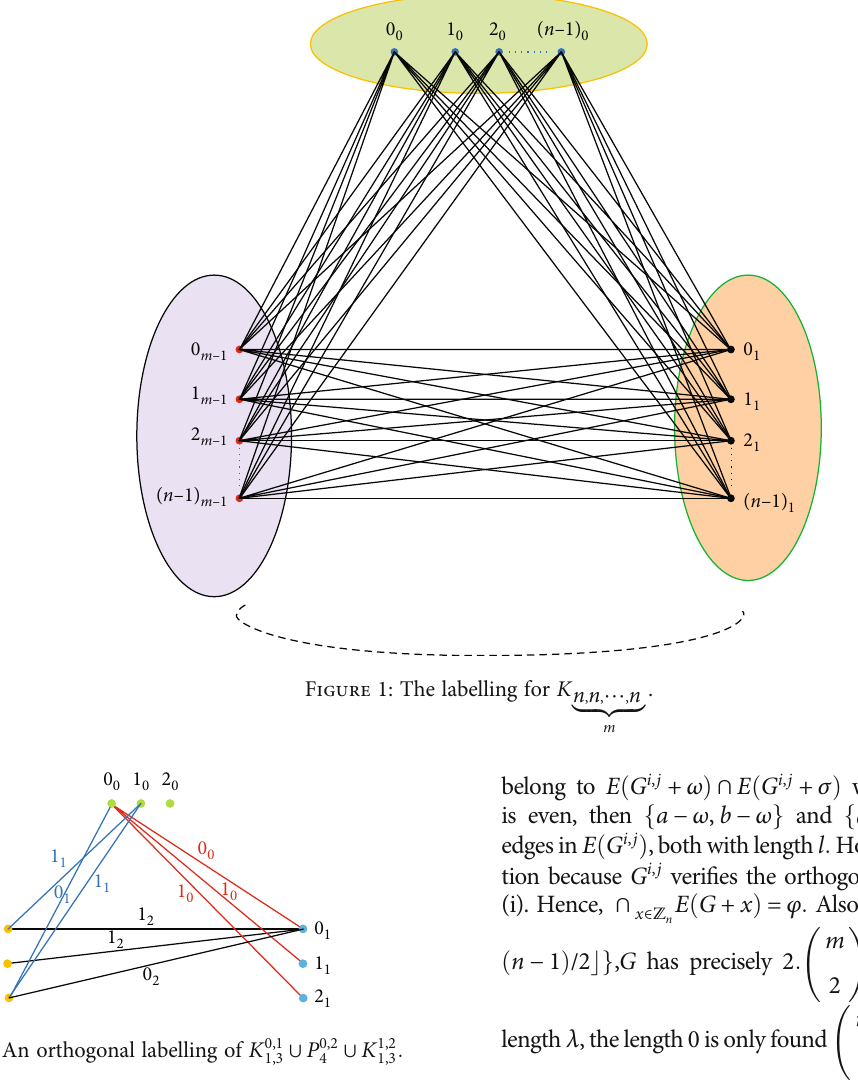
Figure 2: An orthogonal labelling of K 0,1